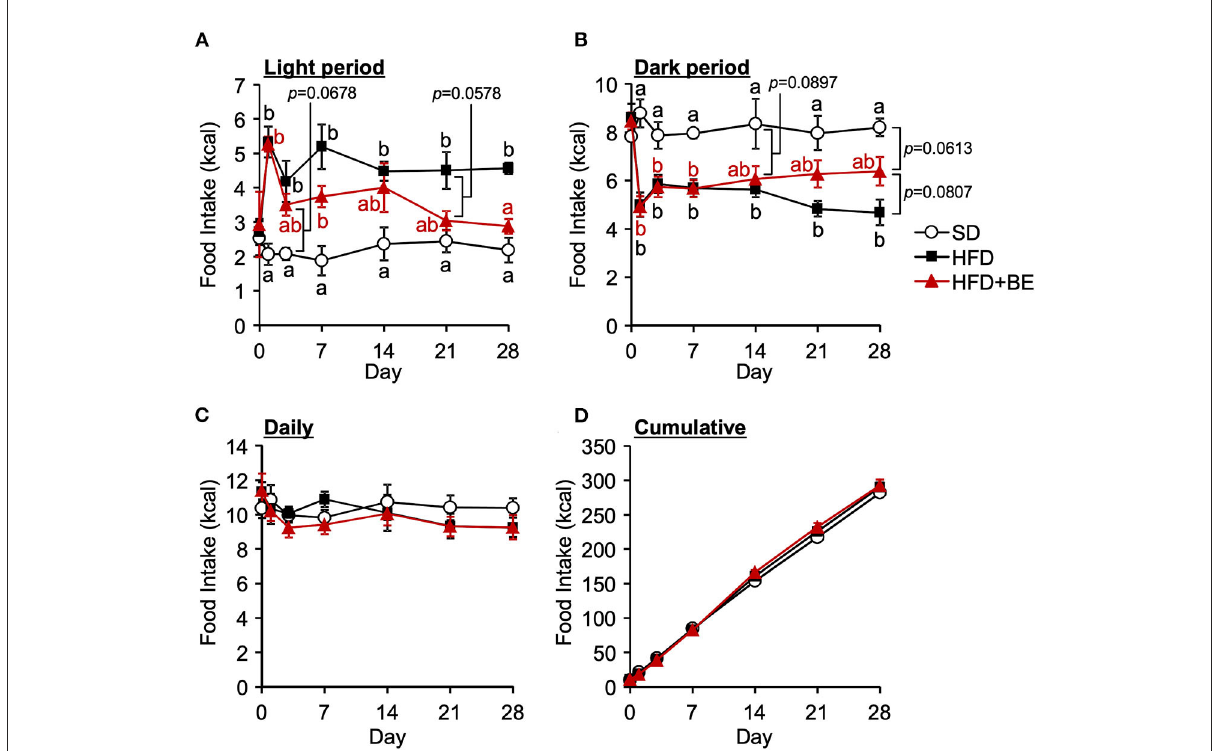
FIGURE4 Effects of HFD and BE on the feeding pattern of mice. Food intake during (A) the light and (B) the dark periods; and (C) the daily and (D) cumulative food intake during the study period. Data shown are mean ± SE ( n = 5). Different letters represent significant differences among the three groups by each experimental period by Tukey-Kramer honestly significant difference test ( p <